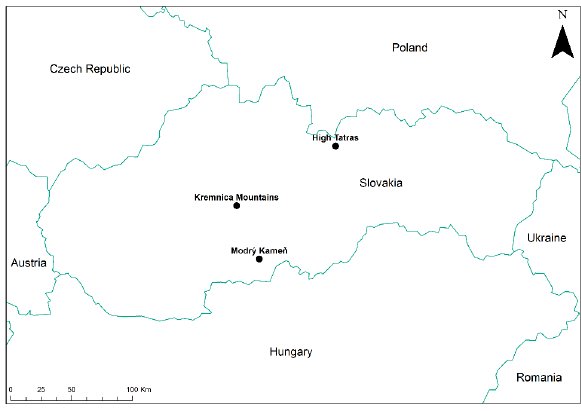
Figure 1. Location of the test plots. Table 1. Test plots characteristics.